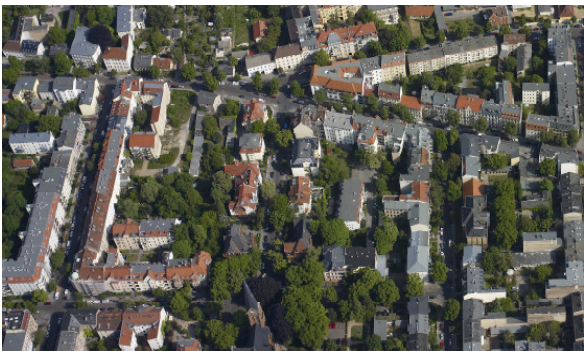
Figure 3: Clipping from an oblique